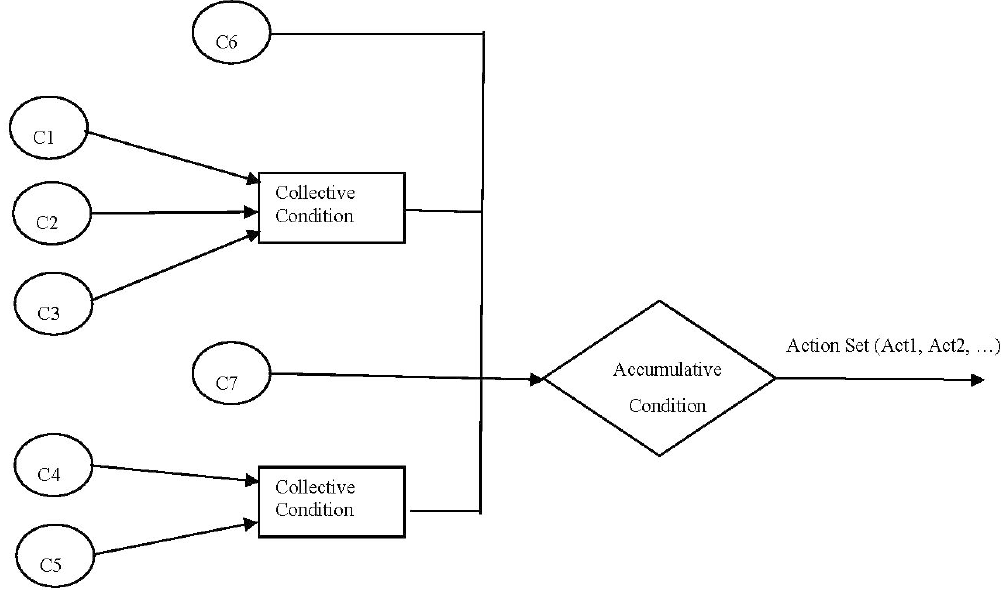
Figure 4. Abstract structure of a rule. Set of optional and mandatory conditions, confidence building, and resultant action.